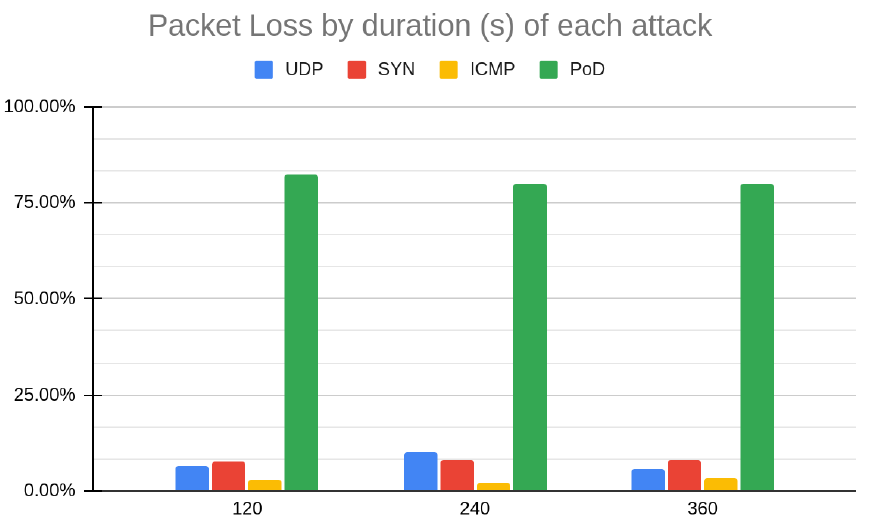
Figure 1. Packet loss during attacks.